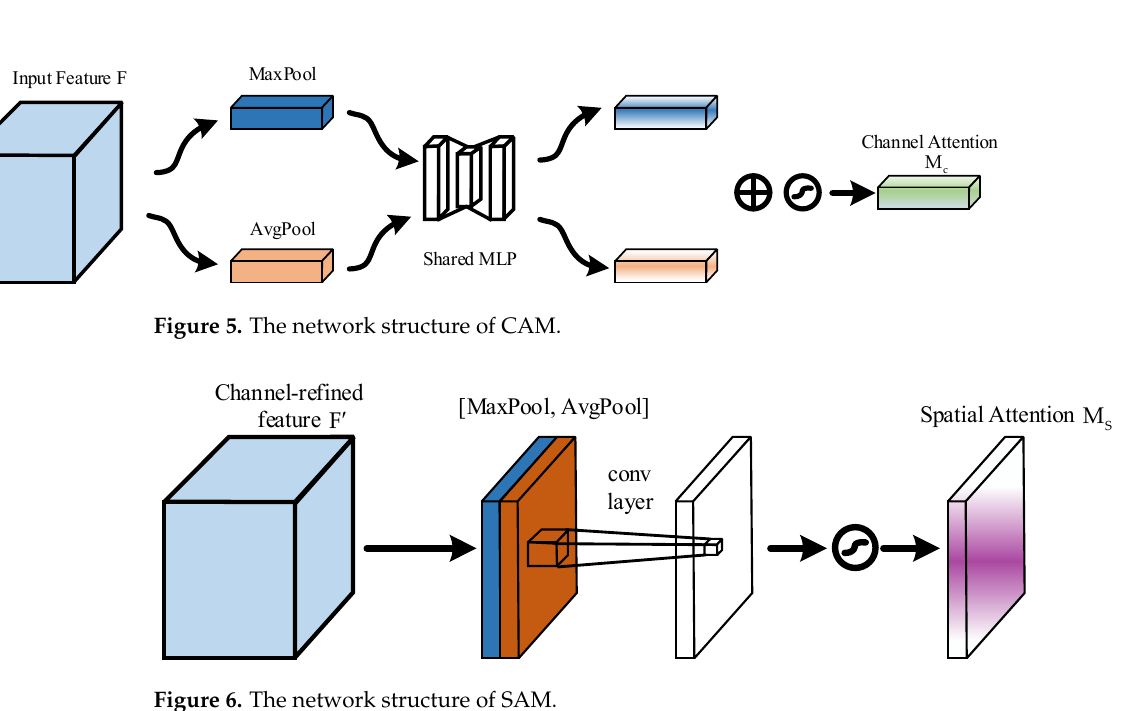
Figure 4. The structure of CBAM.